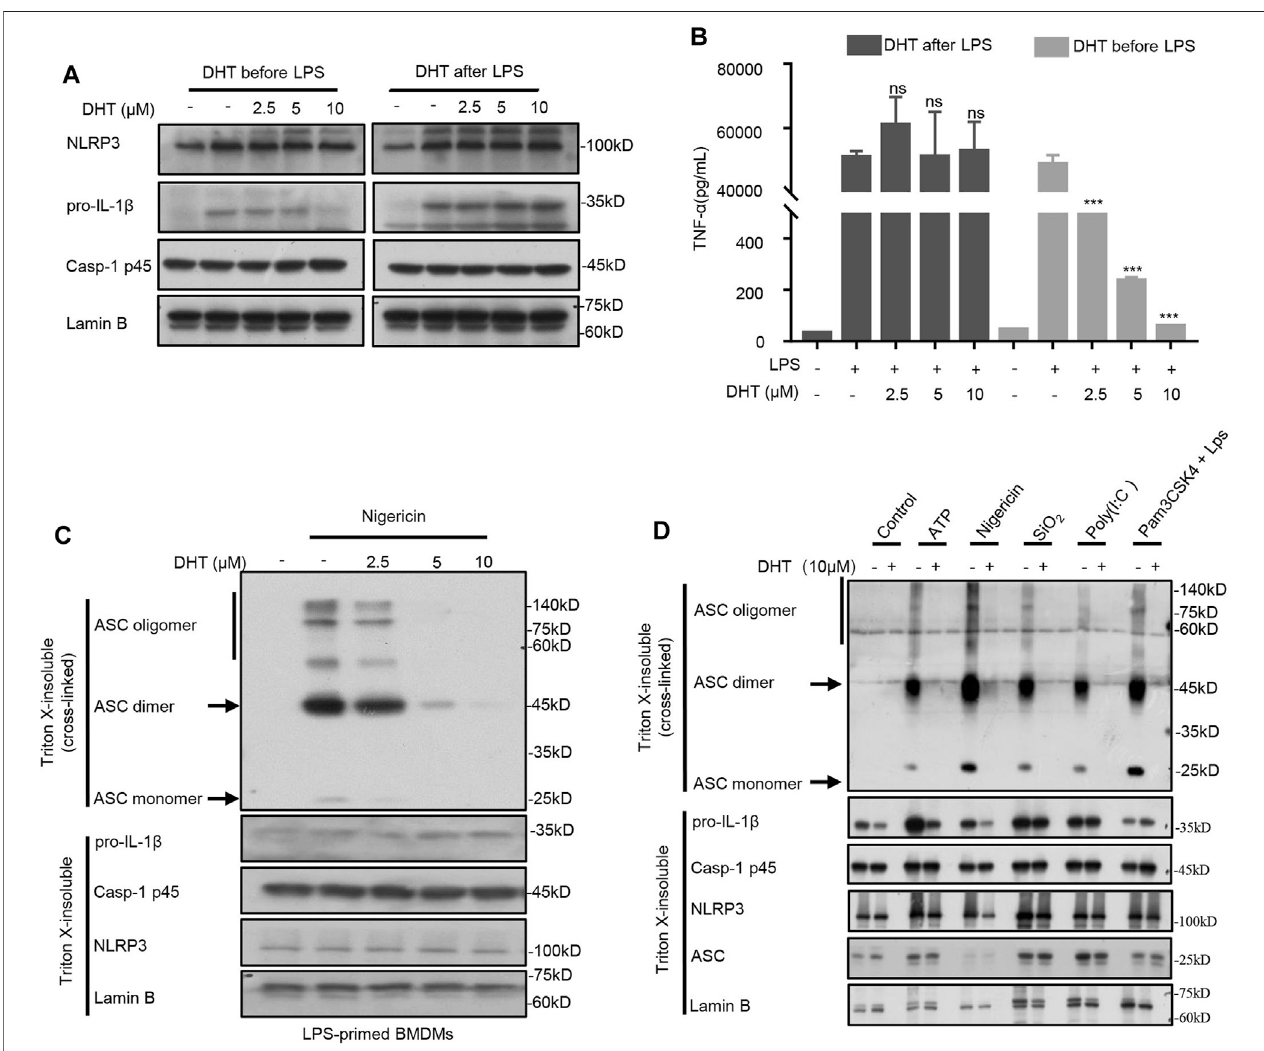
FIGURE 3 | DHT inhibits ASC oligomerization. (A) Western blot analysis of proteins in lysates. from BMDMs with 4 h-LPS priming and then treated with or without different doses of DHT (2.5, 5, 10 μ M) for 1 h, or BMDMs treated with varying doses of DHT (2.5, 5, 10 μ M) for 1 h and then stimulated with LPS for 4 h. Lamin B was used as an internal control. (B) Production of TNF- α in Sup. from BMDMs as described in (A) . (C, D) BMDMs were pretreated with LPS and stimulated with nigericin, ATP, transfected LPS, SiO 2 , poly (I: C), or Pam3CSK4-primed BMDMs stimulated with LPS transfection after exposure to DHT. Western blotting analysis of ASC oligomerization in cell